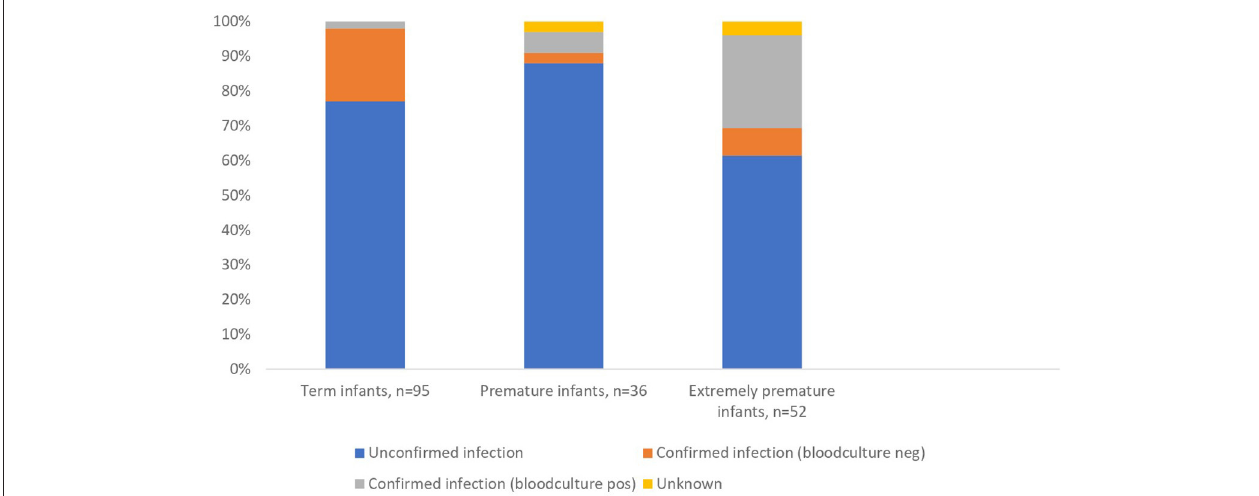
FIGURE 3 | Treatments for early-onset sepsis and late-onset sepsis in two Norwegian neonatal units differentiating between confirmed and unconfirmed infections proportionally.